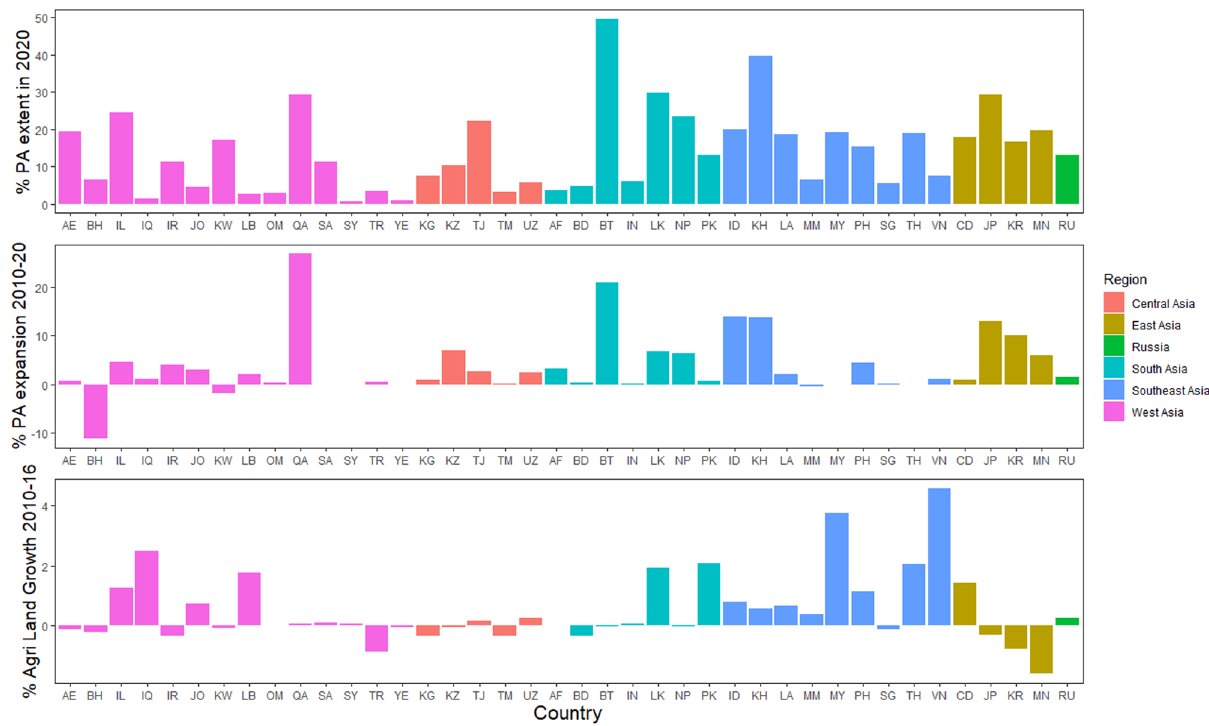
Fig. 2 Barplots showing the arial-based metrics for 40 Asian countries analyzed in this study. Top: the percentage of PA extent in 2020; middle: the percentage of PA expansion between 2010 and 2020 and bottom: the percentage of agricultural land growth between 2010 and